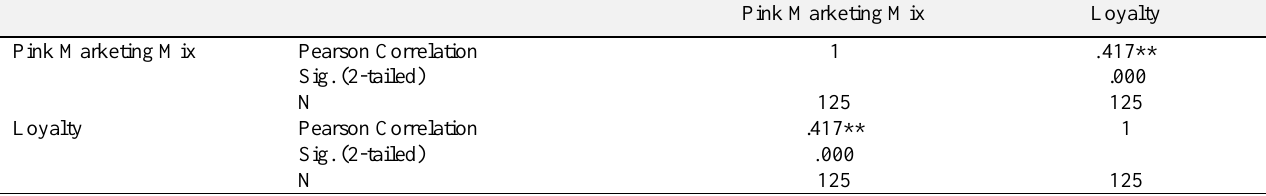
Correlation between Price and loyalty